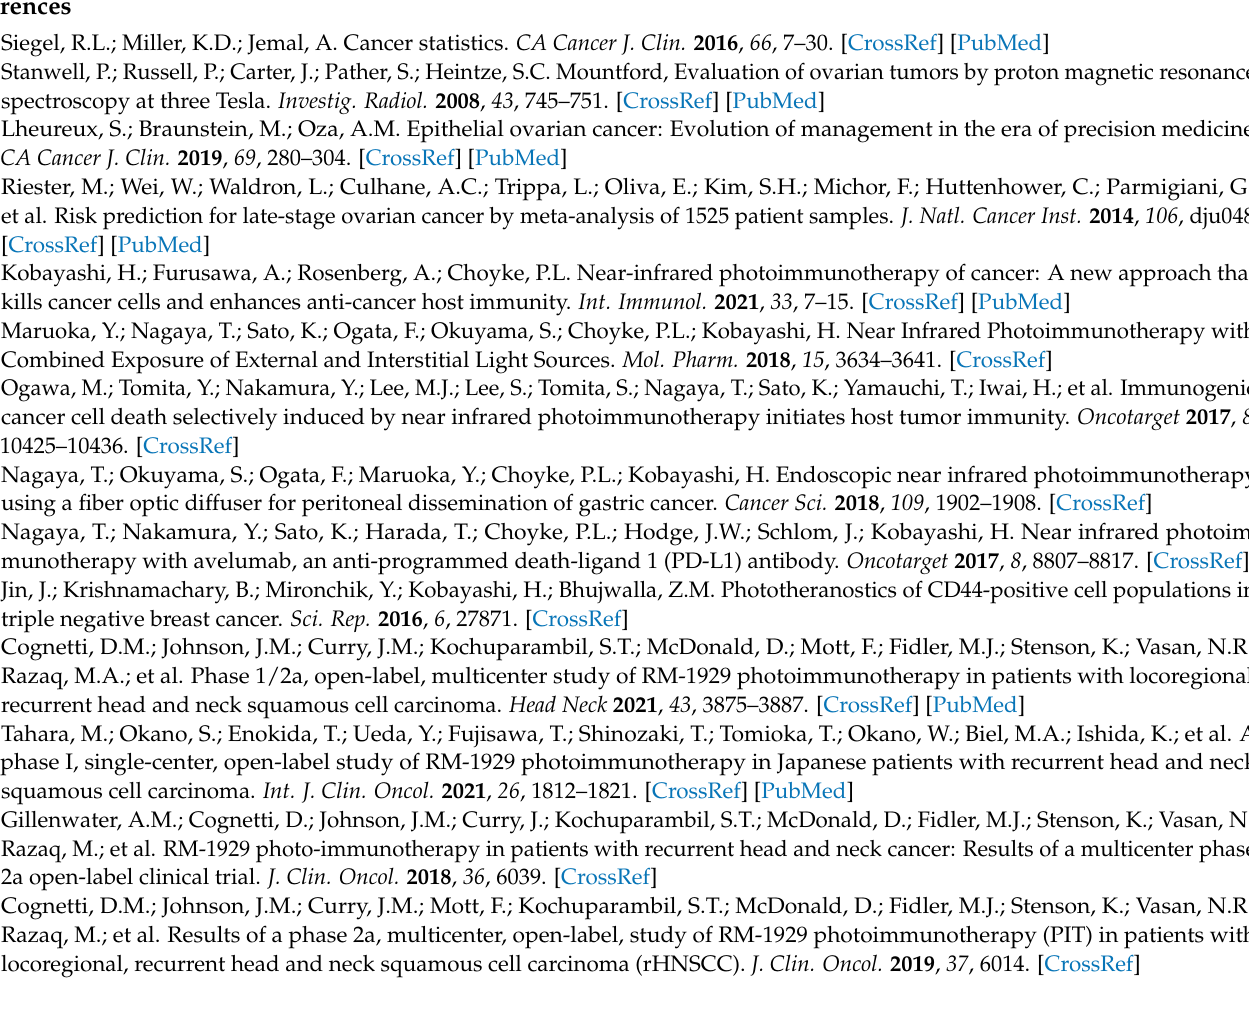
and after photoirradiation, Figure S4: Plasma levels of ALT, AST and BUN in ID8-Defb29-VEGF tumor bearing mice, Figure S5: H&E stained sections of heart from tumor bearing mice, Figure S6: H&E stained sections of kidney from tumor bearing mice, Figure S7: H&E stained sections of liver from tumor bearing mice, Figure S8: H&E stained sections of inflated lungs from tumor bearing mice, Figure S9: H&E stained sections of inflated lungs from a tumor bearing mouse treated with PDL1-IR700 + light showing visible damage, Figure S10: Original